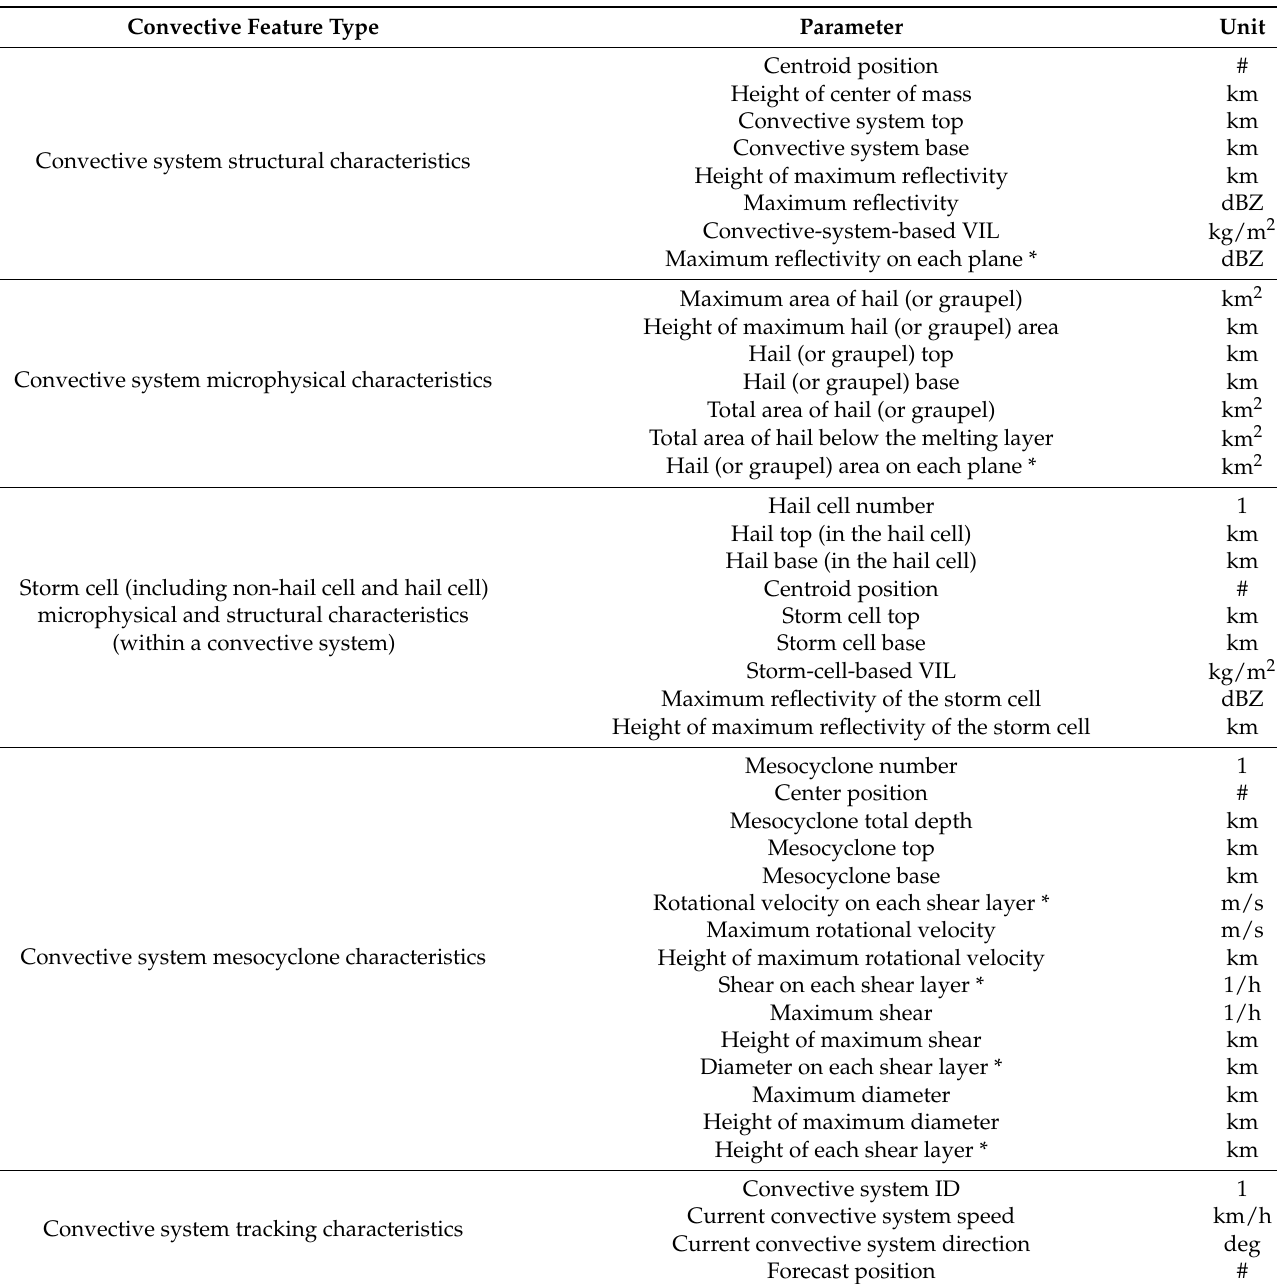
Table 4. Parameters for which the ICCE algorithm produces a